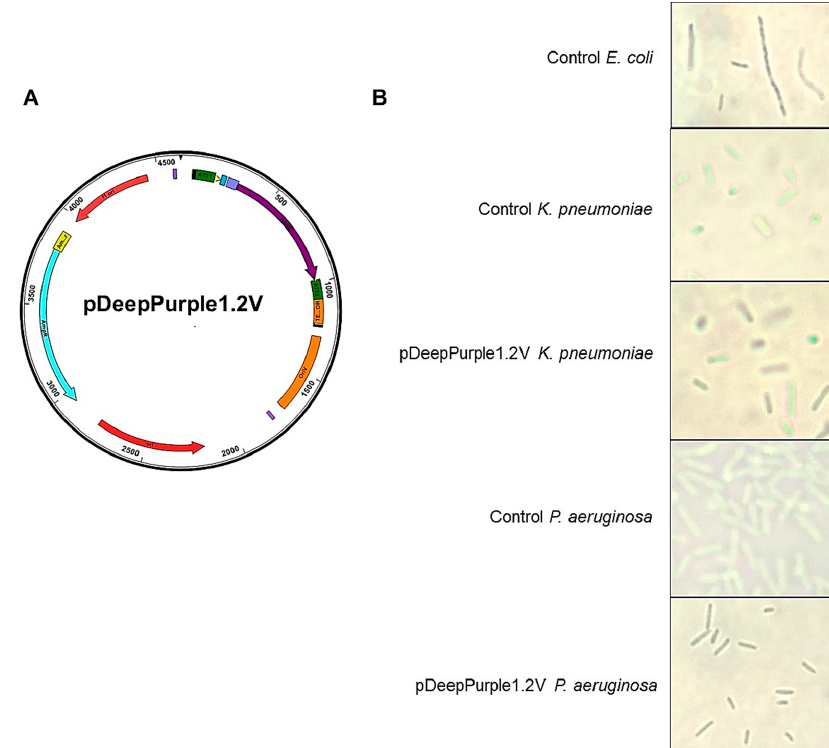
Figure 7. Using AmilCP reporter protein in other bacterial organisms. Panel ( A ) , pGEM T-easy vector containing the cloning cassette with AmilCP (pDeepPurple1.2) was modified by incorporating the OriV replication origin. This plasmid was transformed by electroporation into K. pnreumoniae and P. aeruginosa . Panel ( B ), phenotype analysis by light microscopy (100 × magnification) of the transformed strains. Microorganism and plasmid used is indicated. Two different fields are shown, except for the E. coli